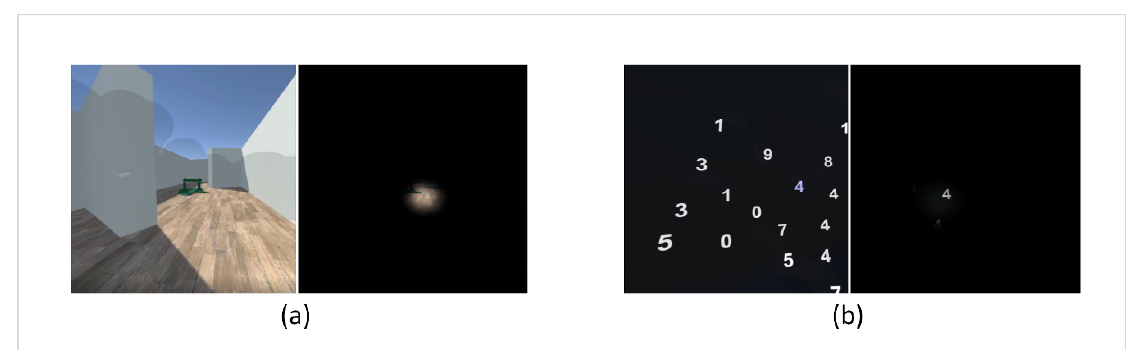
Figure 2. ( a ) Example of a navigation trial from participant’s view, without ( left ) and with ( right ) simulated tunnel vision. The slightly darkened area on the left side image indicates the area already covered by gaze for test and presentation purposes but was completely transparent during trials. ( b ) Example of a search trial from participant’s view without ( left ) and with ( right ) simulated tunnel vision. The digits are randomly distributed search targets. Both images ( a , b ) are captured from the scene render on the laptop screen. The content viewed by the headset user may have varied in proportions due to the influence of the headset’s lenses and different screen shapes.